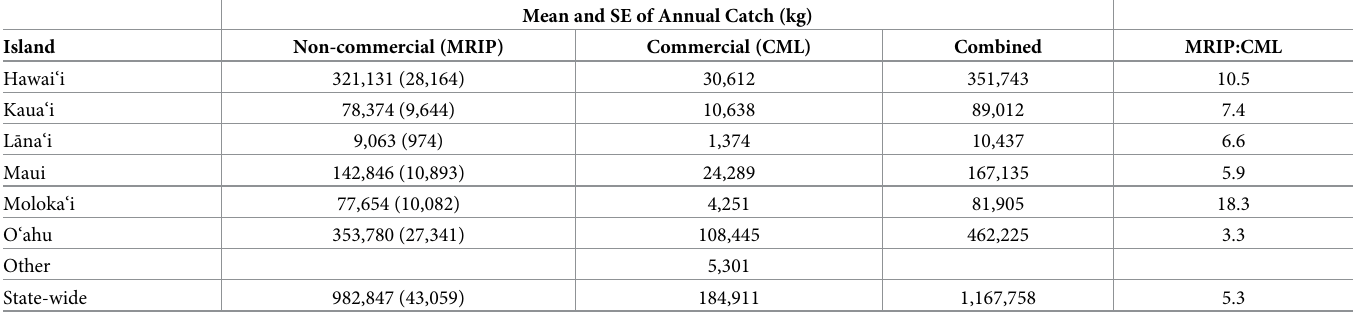
Table 4. Total catch by island in kg year -1 . Values show estimates of commercial and non-commercial catch for each island, as well as a statewide total and combined catch. Yearly estimates are from the time frame of 2004–2013. ‘Other’ for CML comes largely from Ni‘ihau, which has a resident population of ~100 people and is ~30km from Kaua‘i; but also includes catch from offshore banks and